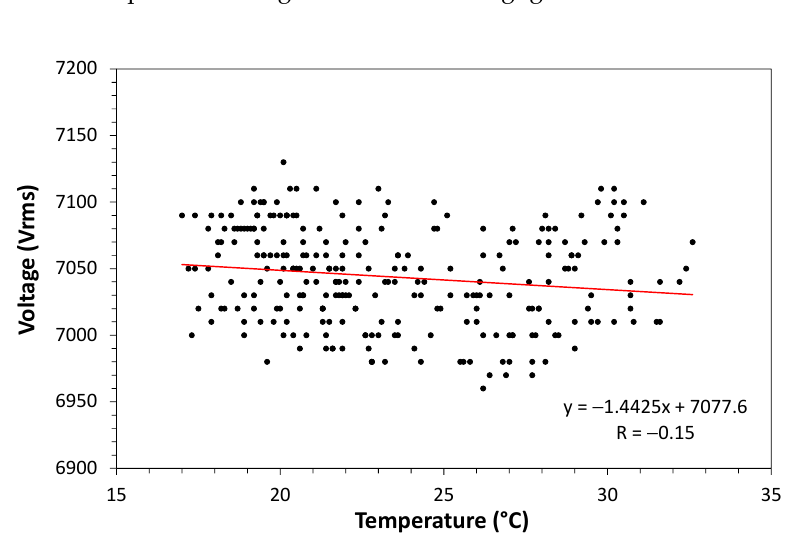
Figure 14. Correlation plot between voltage and temperature obtained from the data of Figure 13.